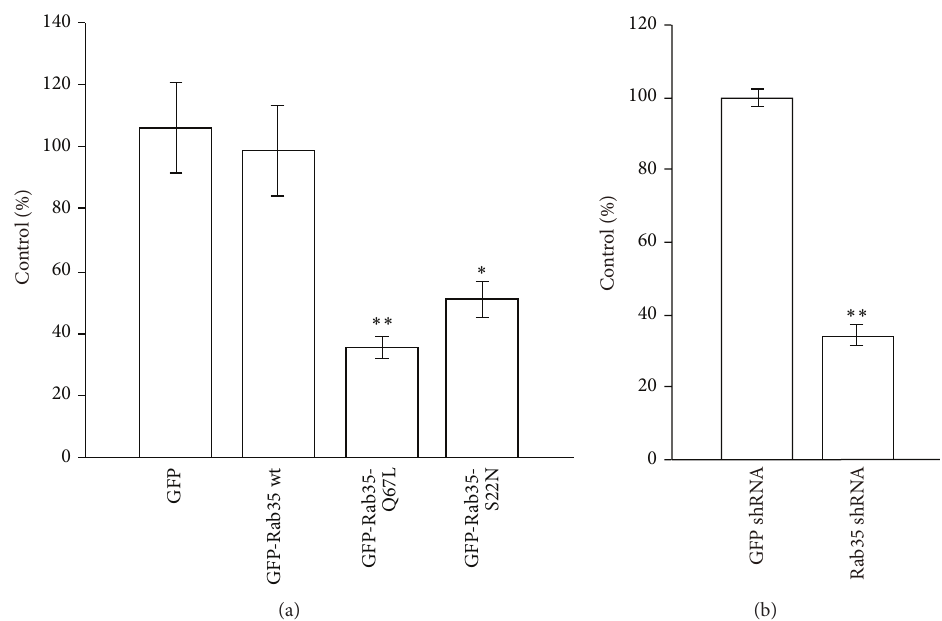
Figure 3: Rab35 regulates phagosome formation. (a) Effect of active and inactive Rab35 mutant expression on zymosan phagocytosis. RAW264 cells expressing each construct indicated were incubated with zymosan and then fixed. The efficiency of phagocytosis was calculated based on 50 transfected and 50 untransfected cells. The results were expressed as a percentage of control (untransfected) cells. The data are expressed as the means ± SEM of four independent experiments. ∗ 𝑝 < 0.05 and ∗∗ 𝑝 < 0.01 compared to GFP transfected cells (Student’s 𝑡 -test). (b) Effect of Rab35 knockdown on phagocytosis of zymosan. RAW264 cells stably expressing RAB35 shRNA or GFP shRNA were incubated with zymosan and were fixed. The efficiency of phagocytosis was calculated based on 50 cells expressing each Rab35 shRNA and 50 control cells stably transfected with GFP shRNA or empty shRNA vector. The results are expressed as a percentage of control cells stably transfected with empty shRNA plasmid. The data are expressed as the means ± SEM of four independent experiments. ∗∗ 𝑝 < 0.01 compared to GFP transfected cells (Student’s 𝑡